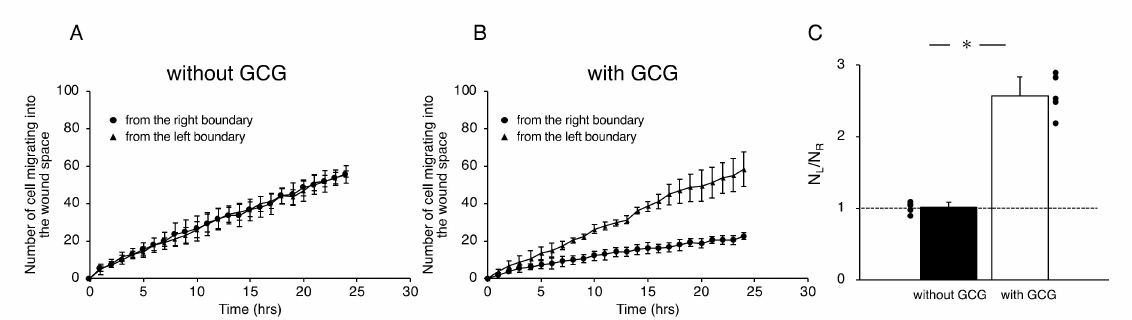
Figure 5. The number of cells that migrated into the wound space in 24 h. ( A ) Without the GCG, the numbers of cells migrating into the wound space from the left boundary and the right boundary were the same. ( B ) With the GCG, the numbers of cells migrating into the wound space from the left boundary and the right boundary were di ff erent, with a statistically significant di ff erence demonstrated after five hours. ( C ) The ratio of the numbers of cells migrating into the wound space from the left boundary and the right boundary determined at 24 h (N L and N R , respectively). The directional migration of MDA-MB-231 cells was clearly demonstrated with involvement of the GCG. Error bars represent the SD. Data were accumulated from five independent experiments. *, p < 0.05, as judged by Student’s t